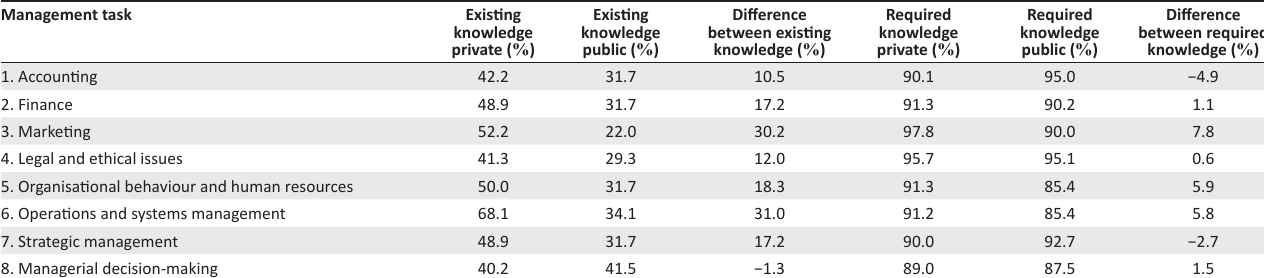
TABLE 5: Comparison of existing and required levels of knowledge between public ( n = 41) and private ( n = 92) working environments. Management